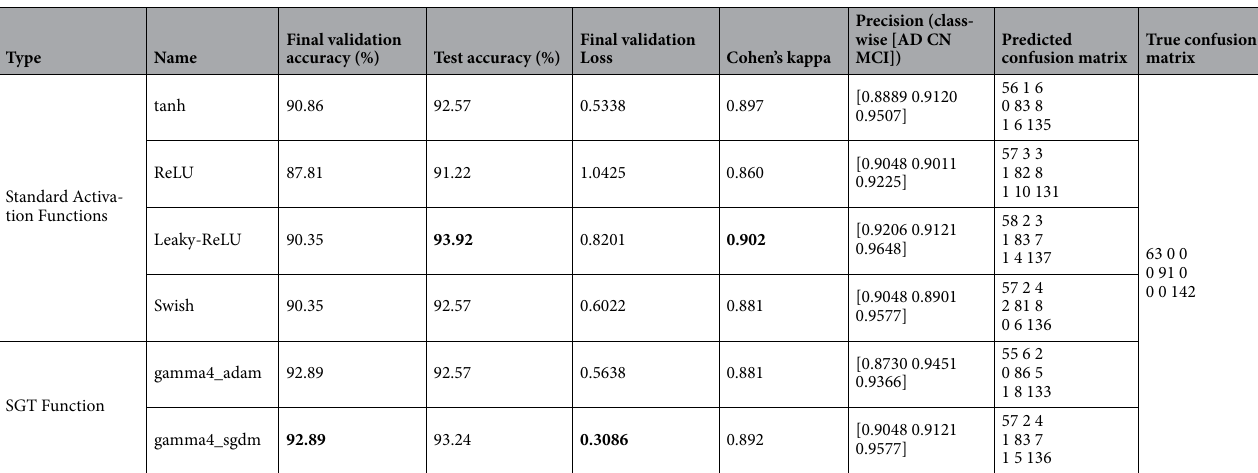
Table 3. Results for multi-class MRI classification using CNN architecture as in Table 2. Bold result in the table content represents the best